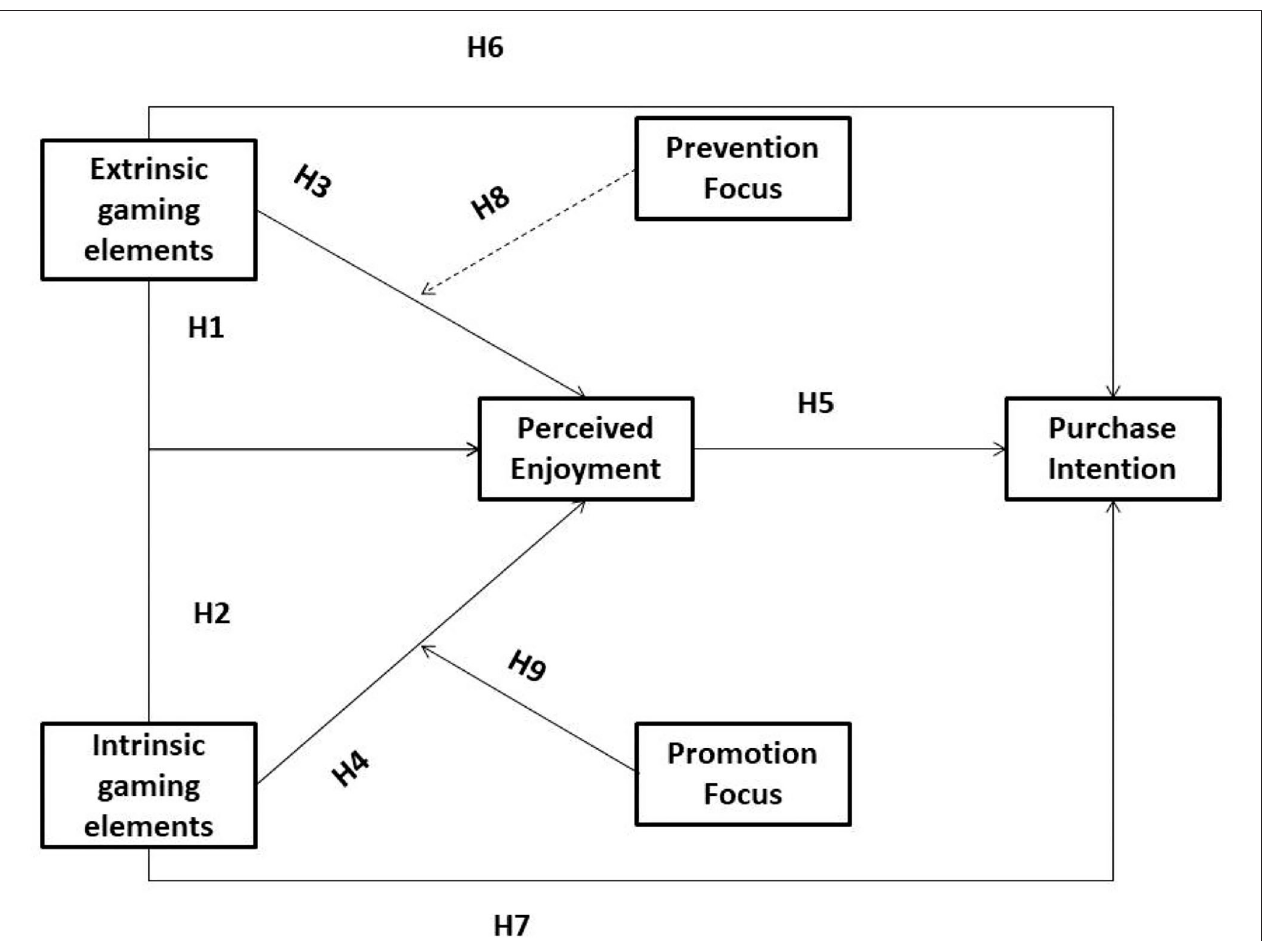
FIGURE 1 | Research